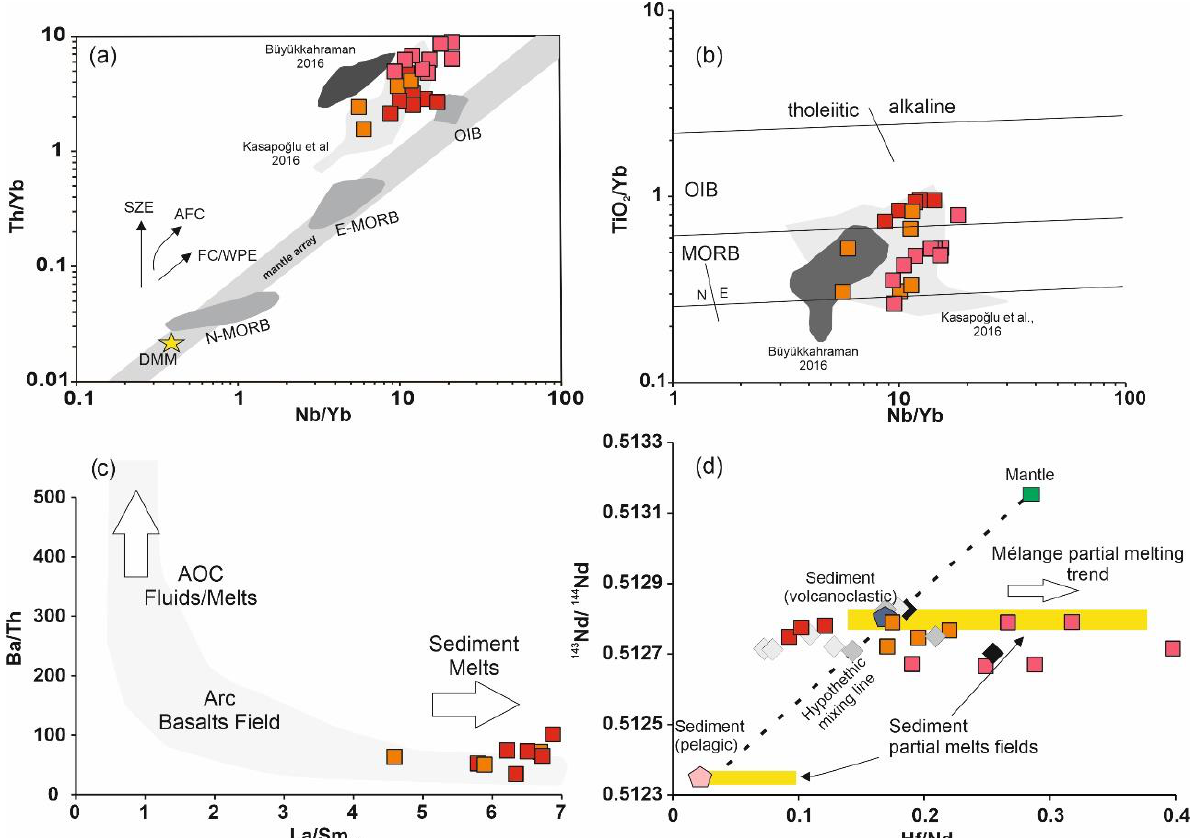
Figure 12. ( a ) Th/Yb vs. Nb/Yb. ( b ) TiO 2 /Yb vs. Nb/Yb plots of [51] The fields for Ocean Island Basalts (OIB), Enriched- and Normal-Mid Ocean Ridge Basalts (E- and N-MORB) are from [60,61]. ( c ) La/Sm (n) vs. Ba/Th diagram that differentiates altered oceanic related fluid melts vs. subducted sedimentary related inputs. ( d ) 143 Nd/ 144 Nd vs. Hf/Nd diagram that tracks the partial melting of mélange material in accretionary/collisional settings [55]. For comparison, data from [25,38] were also plotted.